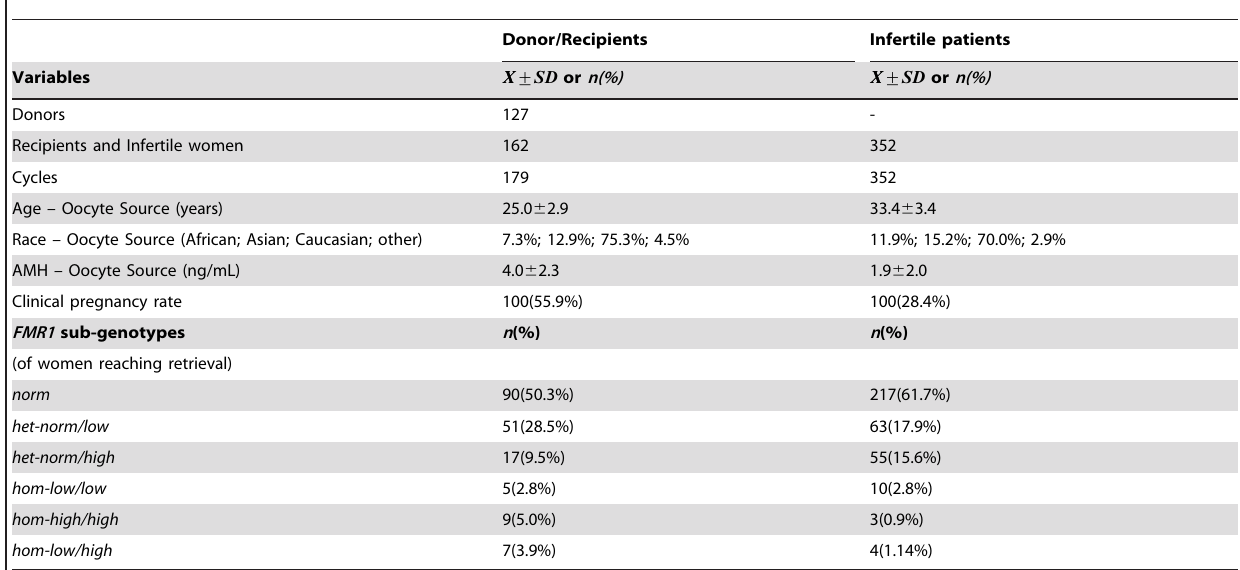
Table 3. Donor egg recipients and infertility patients using autologous oocytes included in section